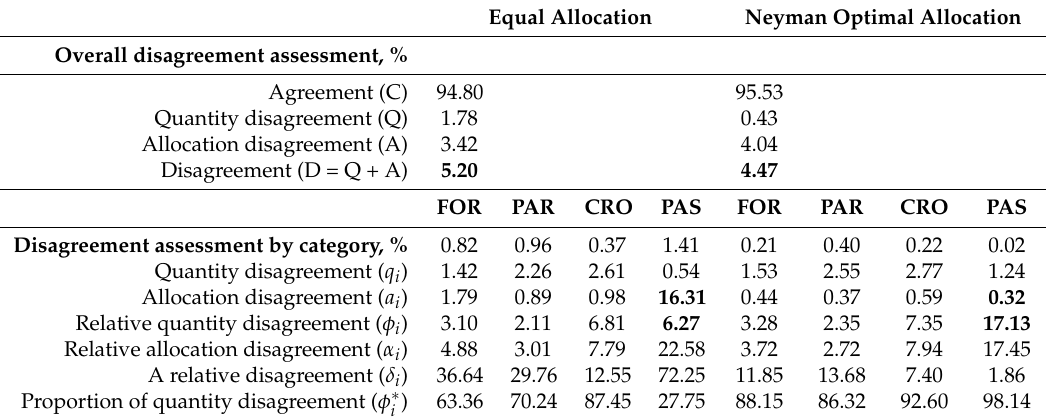
Table 10. Relative quantity and allocation disagreement measure for category-level accuracy assessment; Forest (FOR), P á ramo (PAR), Crop (CRO), and Pasture (PAS). The relative quantity and allocation disagreement was performed for equal and Neyman allocation of sample in each stratum. The equal allocation is from the first map estimation stage and the Neyman optimal allocation from the second stage of accuracy assessment (Figure